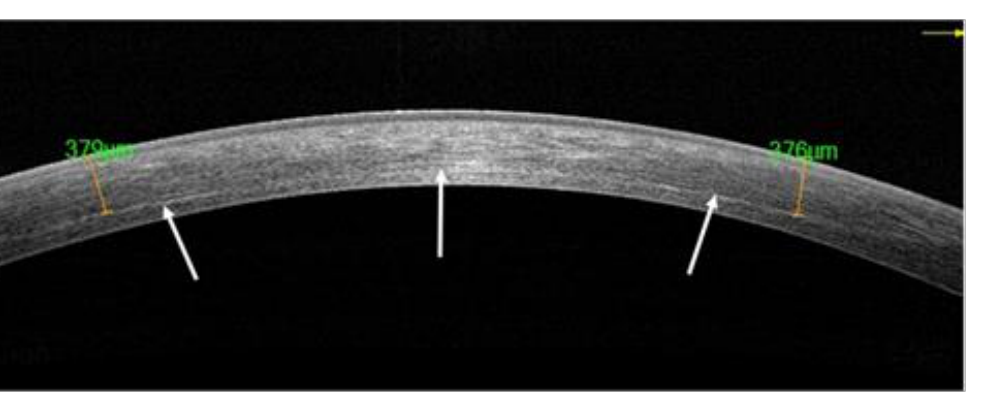
Figure 5. ( a ) Preoperative endothelial cell count; ( b ) Postoperative endothelial cell count.